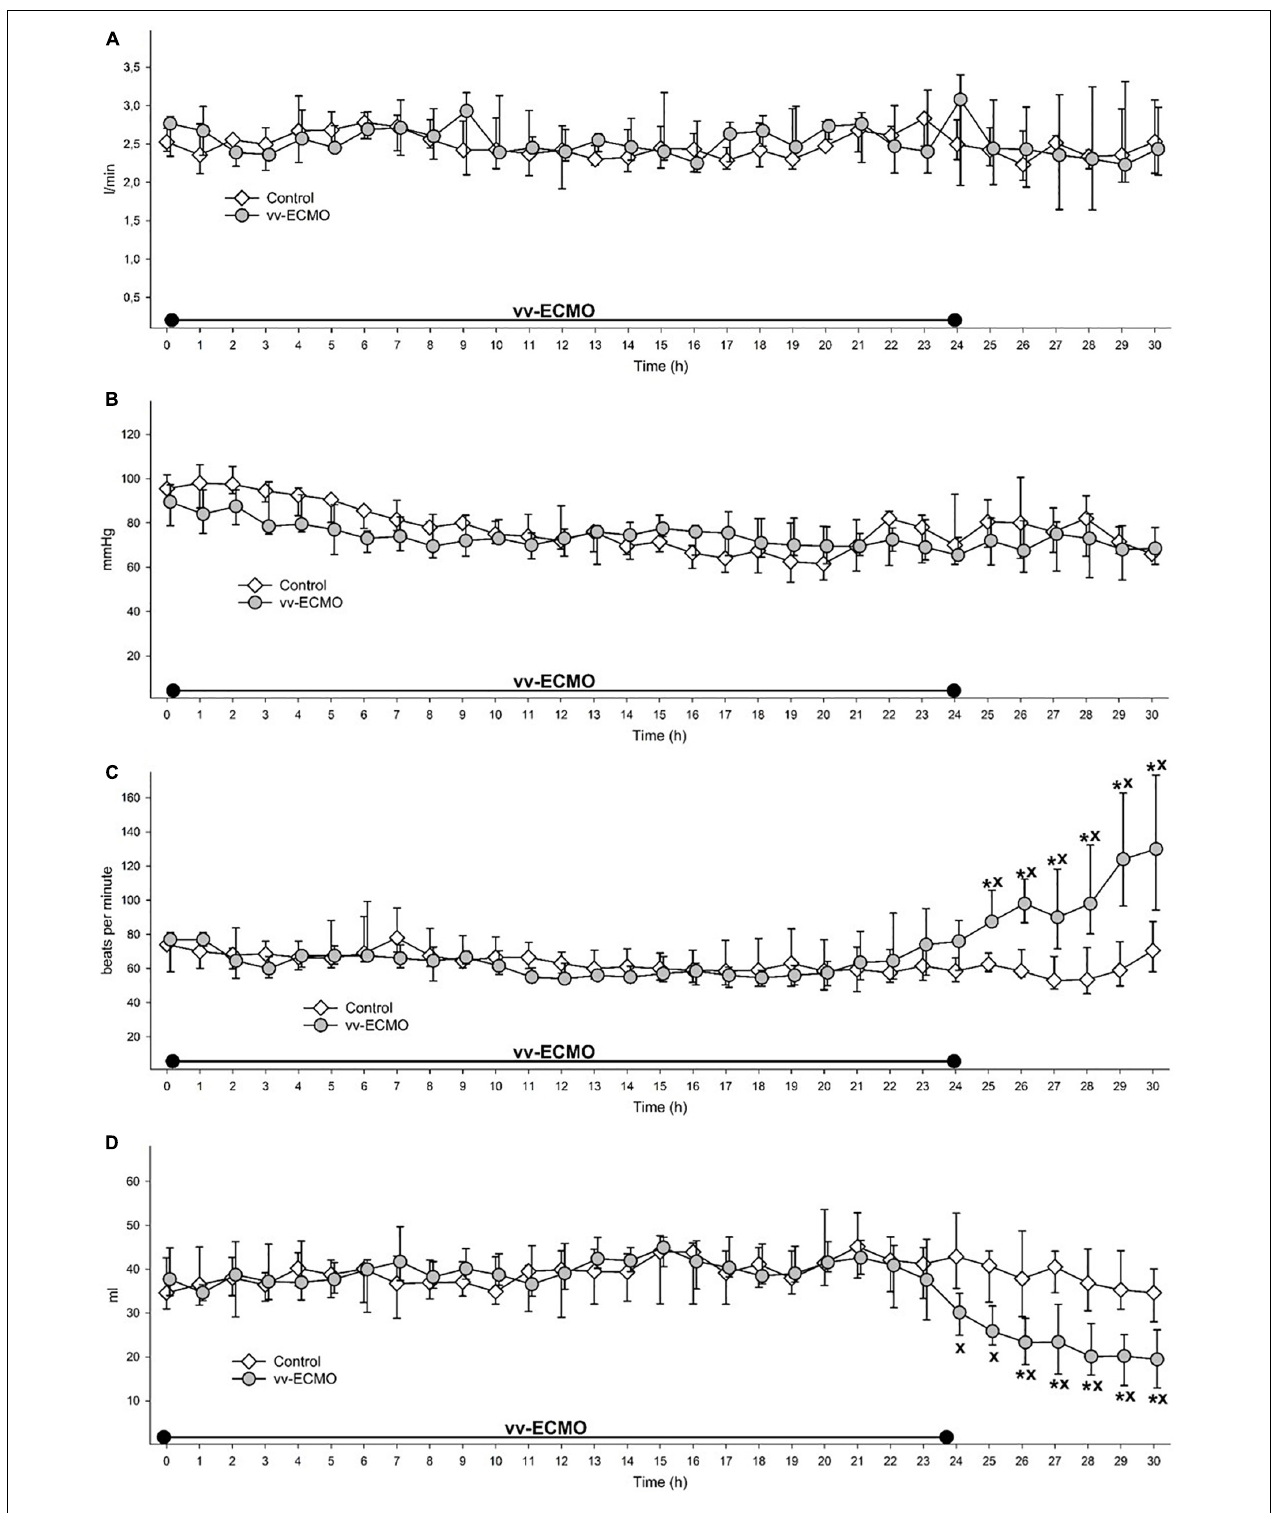
FIGURE 2 | Changes in cardiac output (A) , mean arterial pressure (B), heart rate (C) and stroke volume (D) during the whole observation period in the control group (empty diamonds joined by a thin continuous line) and vv-ECMO group (gray circles joined by a continuous line). The plots demonstrate the median and the 25th (lower whisker) and 75th (upper whisker) percentiles. * P < 0.05 for the groups vs. baseline values (Friedman and Dunn tests). x P < 0.05 for the vv-ECMO vs. control group values (Mann–Whitney test).